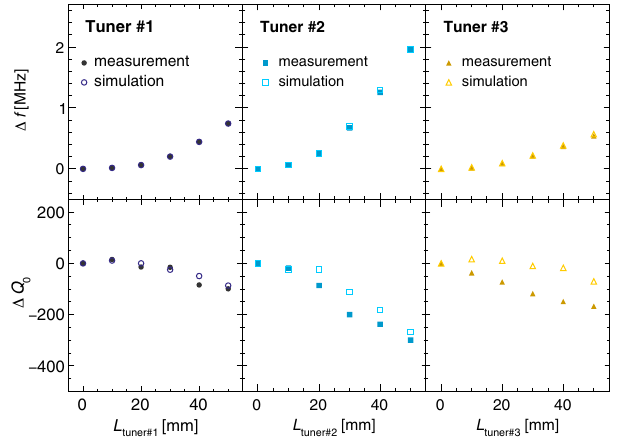
FIG. 8. Top: frequency shift as functions of the tuner insertion lengths of each tuner. The tunable ranges with the three tuners were 3.24 and 3.27 MHz in the measurement and simulation, respectively. (bottom) The unloaded Q ( Q 0 ) shift dependence on L tuner